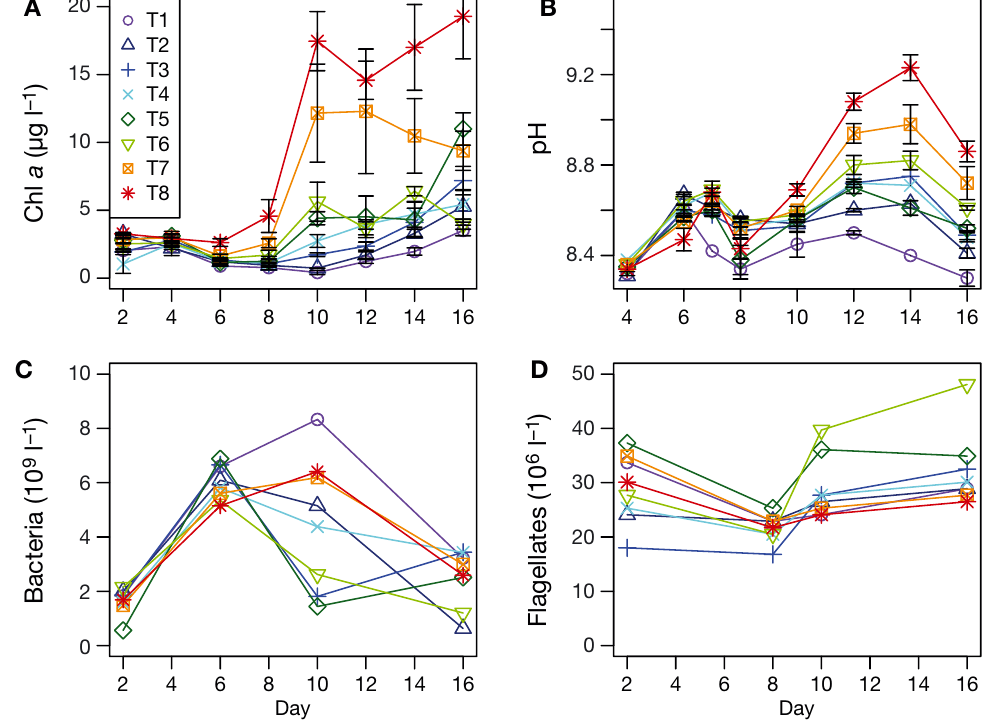
Fig. 2. Development of (A) chlorophyll a (chl a ) concentration, (B) pH, (C) abundance of DAPI-stained bacteria and (D) proflavine-stained nanoflagellates from the microcosm experiment. T1−8 refer to the nutrient-loading treatments described in Table 1. (C) and (D) modified from L. Olsen et al.